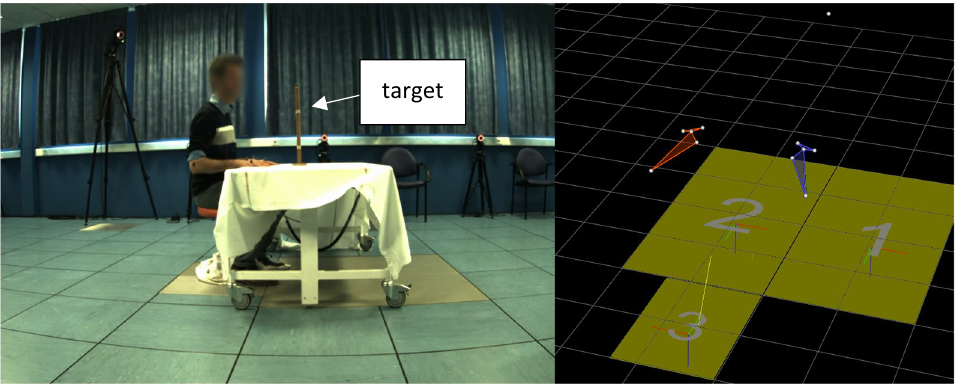
Figure 1. Experimental set up: starting position and target ( left ). Representation of reflective markers in Vicon software ( right ).